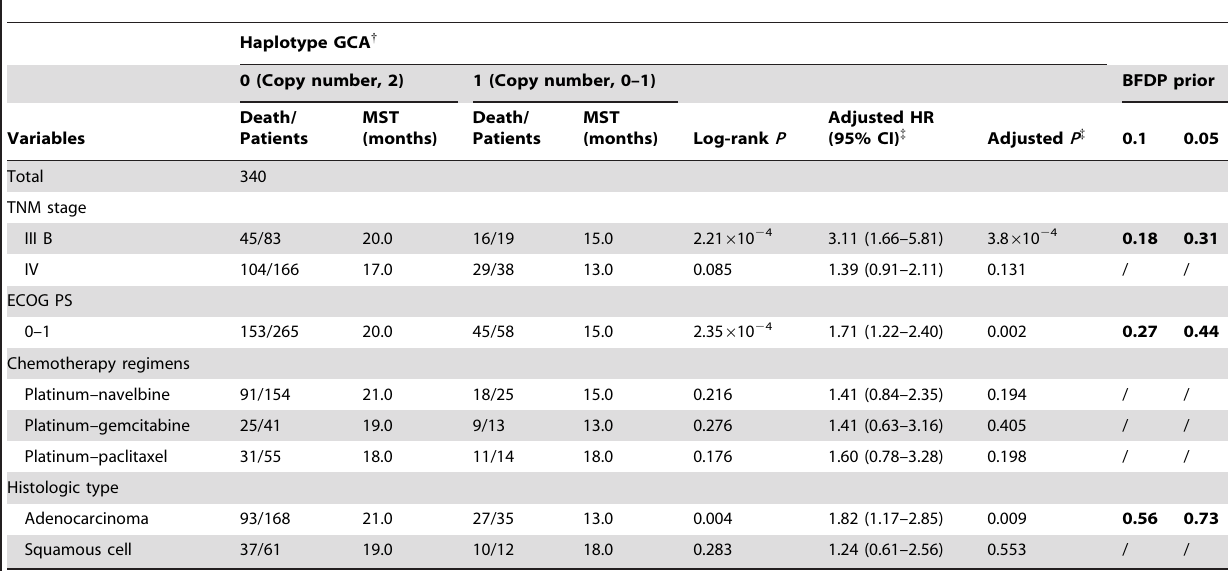
Table 5. Subgroup analysis of association between XPD haplotype and overall survival.